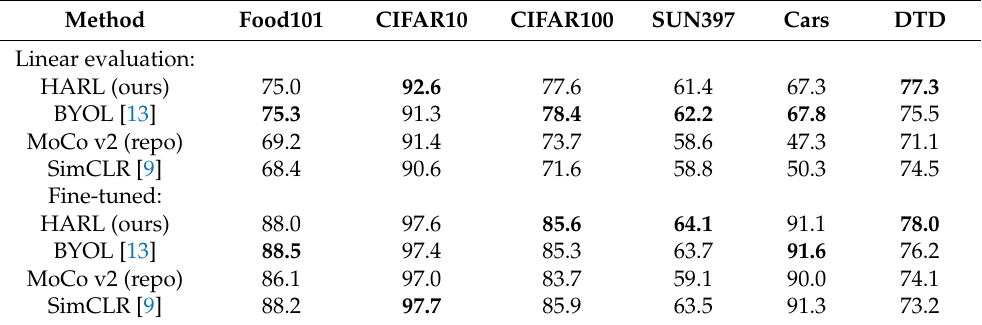
Table 2. Transfer via fine-tuning on the image classification task. The transfer learning perfor- mance between HARL framework and other self-supervised baseline benchmarks across six natural image classification datasets with the self-supervised pre-trained representation on the ImageNet 1000 classes using the standard ResNet-50 backbone. The best result is bolded.